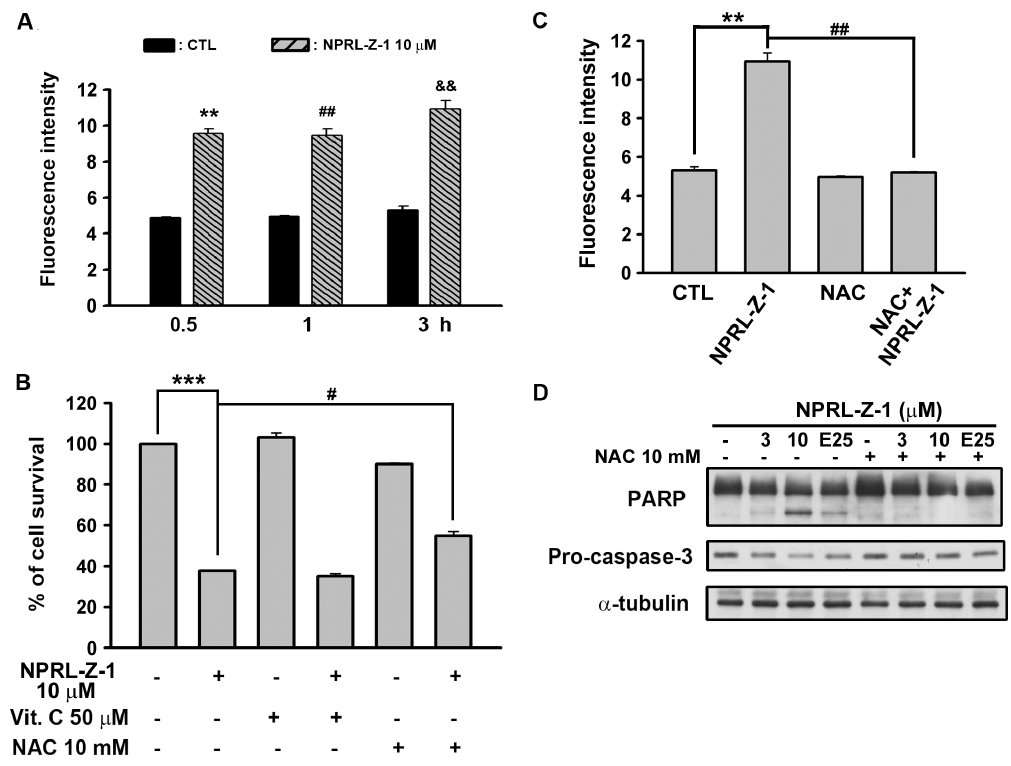
Figure 8. Effect of NPRL-Z-1 on cellular ROS accumulation in A498 cells. A498 cells were incubated in the absence or presence of NPRL-Z-1 (10 m M) for indicated time. The fluorescent intensity of DCFH-DA was detected by flow cytometric analysis. ** P , 0.01 compared with the 0.5 h-time point control group. ## P , 0.05 compared with the 1 h-time point control group. && P , 0.01 compared with the 3 hr-time point control group. (B) Different ROS scavengers were preincubated for 30 min and cell viability was determined by MTT assay. *** P , 0.001 compared with the control group. # P , 0.05 compared with the NPRL-Z-1-treated group. Treatment of NAC inhibited NPRL-Z-1-induced ROS generation (C, ** P , 0.01 and ## P , 0.01 compared with the NPRL-Z-1-treated group.). (D) NAC (10 mM) reduced the apoptosis-related results in NPRL-Z-1-treated cells for 24 h. E25 indicated as etoposide 25 m M. TOP2 b expression via western blotting. Figure S2. Effects of etoposide on cell cycle distribution in A498 cells. Cells were incubated with vehicle or various concentrations of etoposide for 24 h and detected cell cycle distribution by flow cytometry. Figure S3. Effects of NPRL-Z-1 in ACNH cells. (A) NPRL- Z-1 induced PARP cleavage. (B) NPRL-Z-1 induced DNA checkpoints activation. (C) Transfection of siTOP2 a or siTOP2 b could reverse NPRL-Z-1-induced cell death in ACHN cells. (DOCX)